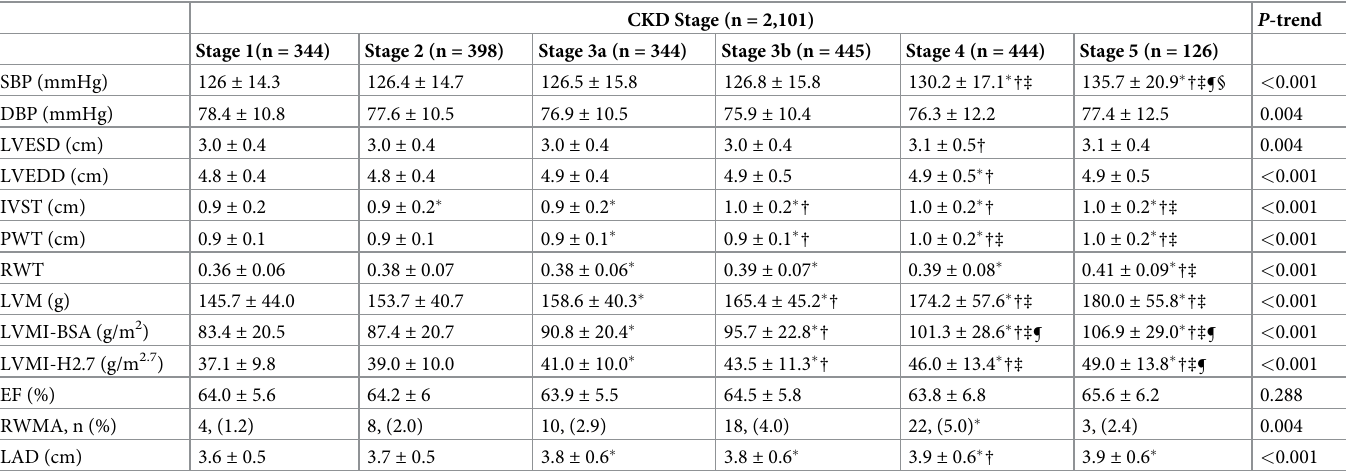
Table 2. Trends of echocardiographic parameter according to CKD stages.